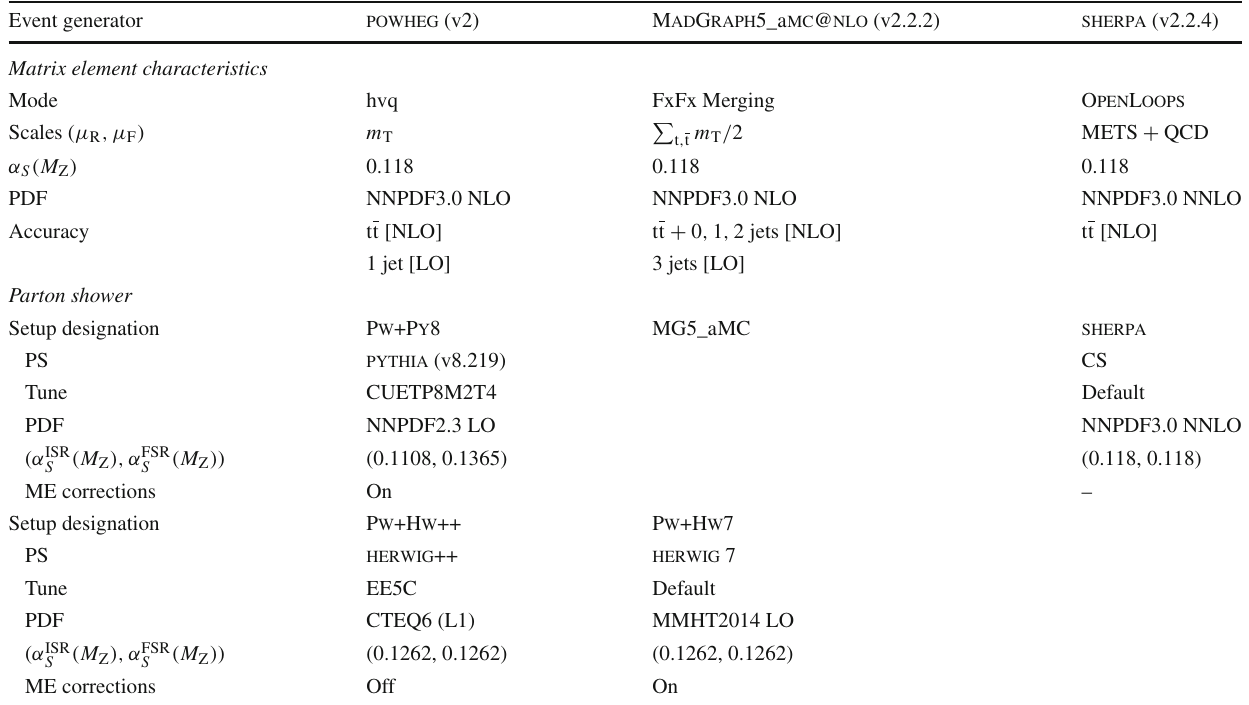
Table 1 MC simulation settings used for the comparisons with the dif- generators. The row labeled “Setup designation” shows the definitions ferential cross section measurements of the UE. The table lists the main of the abbreviations used throughout this paper characteristics and values used for the most relevant parameters of the Event generator powheg (v2) MadGraph 5_a mc@nlo (v2.2.2) sherpa (v2.2.4)